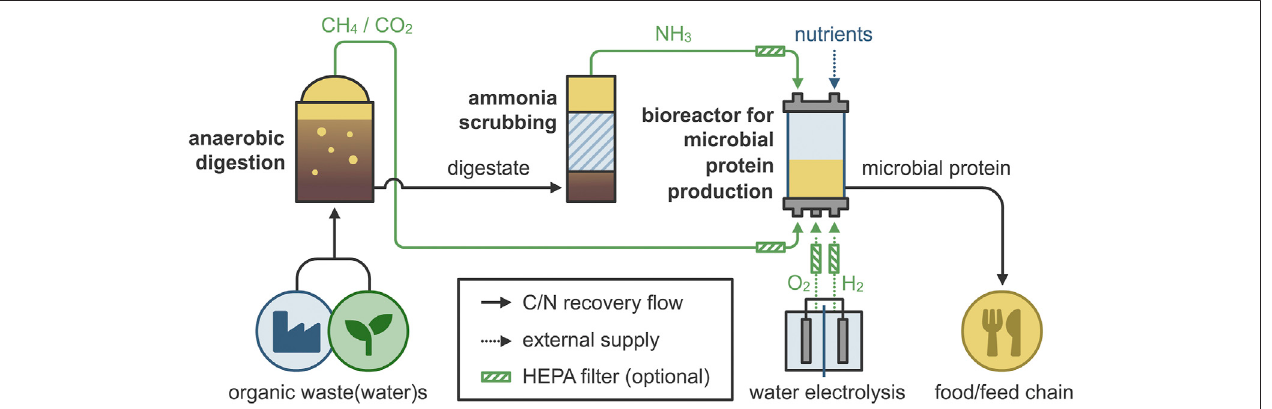
FIGURE 1 | The gas clearance concept for microbial protein production. Organic waste is anaerobically digested to produce methane (CH 4 ) and carbon dioxide (CO 2 ),whileammonia(NH 3 )isrecoveredthroughstripping.Next,hydrogen(H 2 )andoxygen(O 2 )areproducedfromwaterelectrolysisusingrenewableenergy,andboth aresupplementedinthebioreactorformicrobialproteinproduction, alongwiththerequirednutrients.Afterthenecessarydownstream processing, themicrobialprotein can be used as food or feed